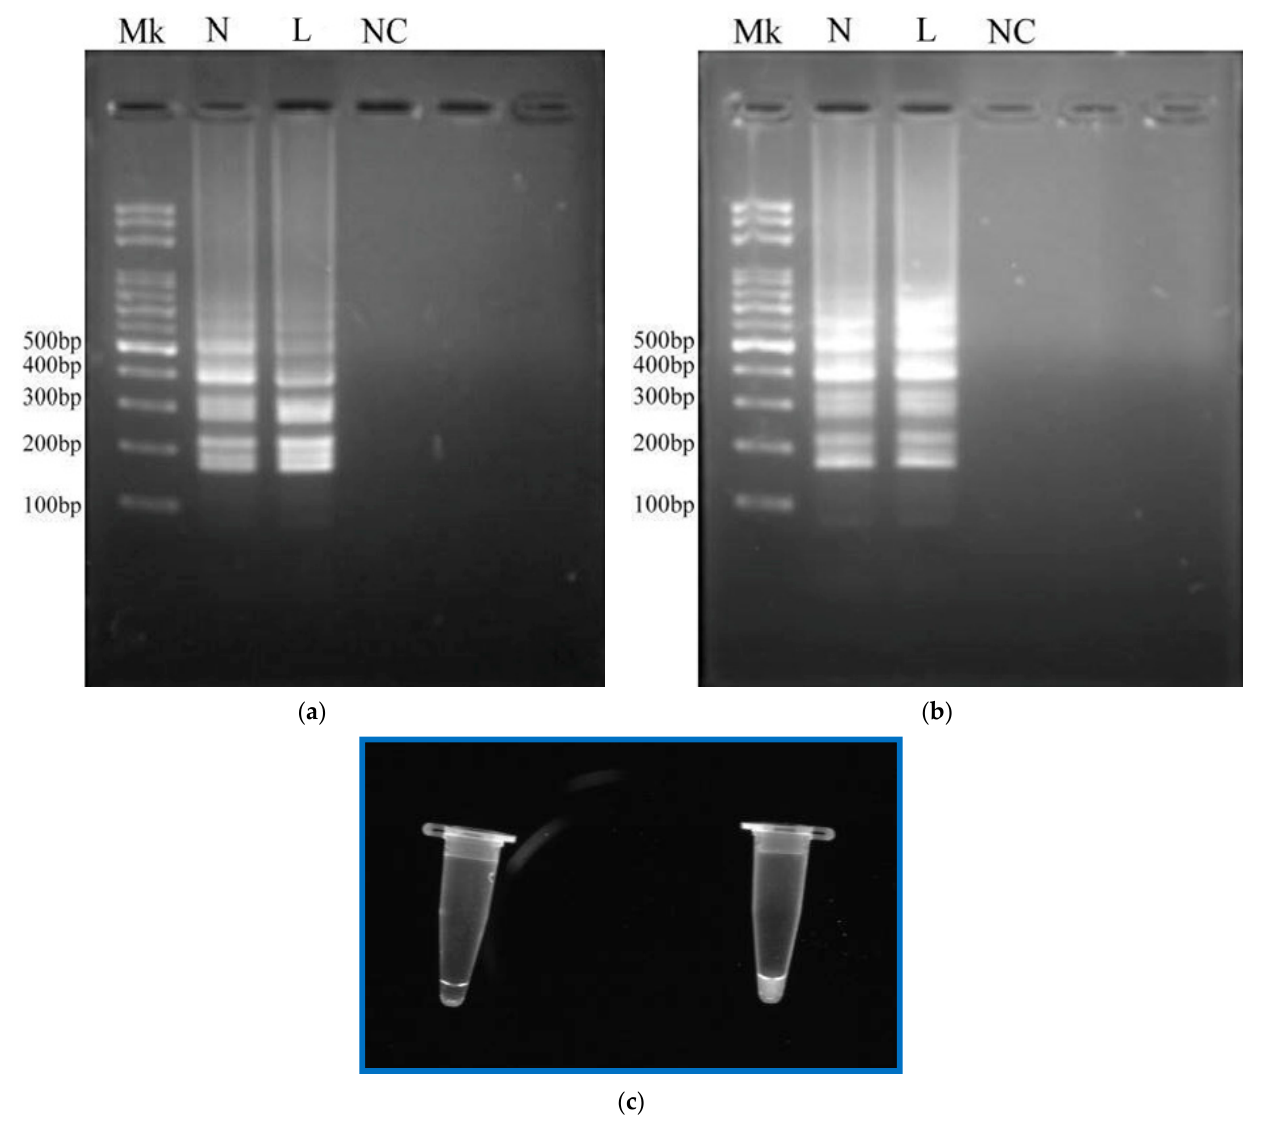
Figure 4. ( a ) Agarose gel electrophoresis of the LAMP yield before temperature calibration. Lane (Mk): DNA ladder; lane (N): positive control from the conventional PCR machine; lane (L): LAMP product from the portable device; lane (NC): negative control without DNA template. ( b ) Agarose gel electrophoresis of the LAMP yield after temperature calibration. Lane (Mk): DNA ladder; lane (N): positive control from the conventional PCR machine; lane (L): LAMP product from the portable device; lane (NC): negative control without DNA template. ( c ) Turbidity in the sample tube under the UV light for the negative sample (at the left side) and the positive sample (at the right